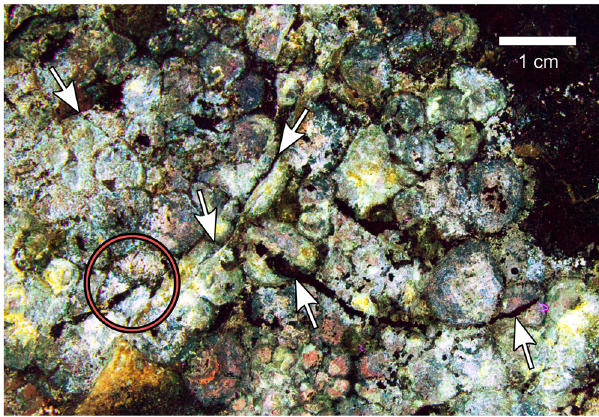
Fig. 3 Photograph of a portion of ‘ side B ’ of NHMUK R1868 under laser- stimulated fl uorescence, showing diagenetic fragmentation of epidermal scales. Location within the entire block is indicated in Fig. 2a. Arrows identify several scales in various stages of fragmentation, while the red circle surrounds three separated fragments, which are interpreted to form a single scale that has broken apart. Scale bar as